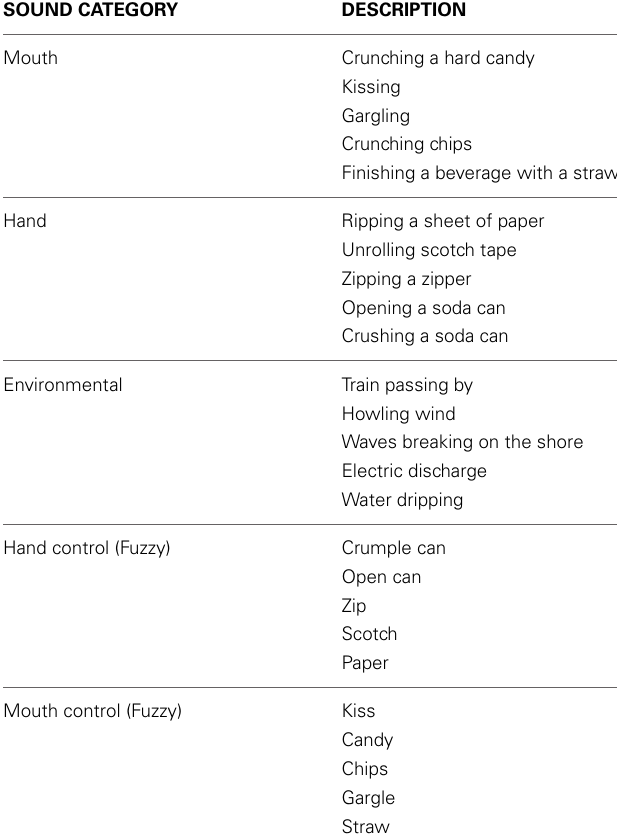
Table 1 | Auditory stimuli used for Studies 1 and 2. SOUND